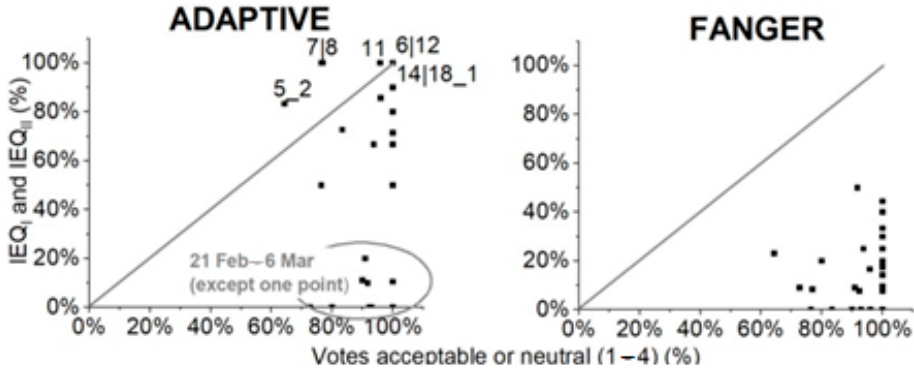
Figure 11. Relationship between theoretical models and surveys’ votes for correct levels of comfortability.